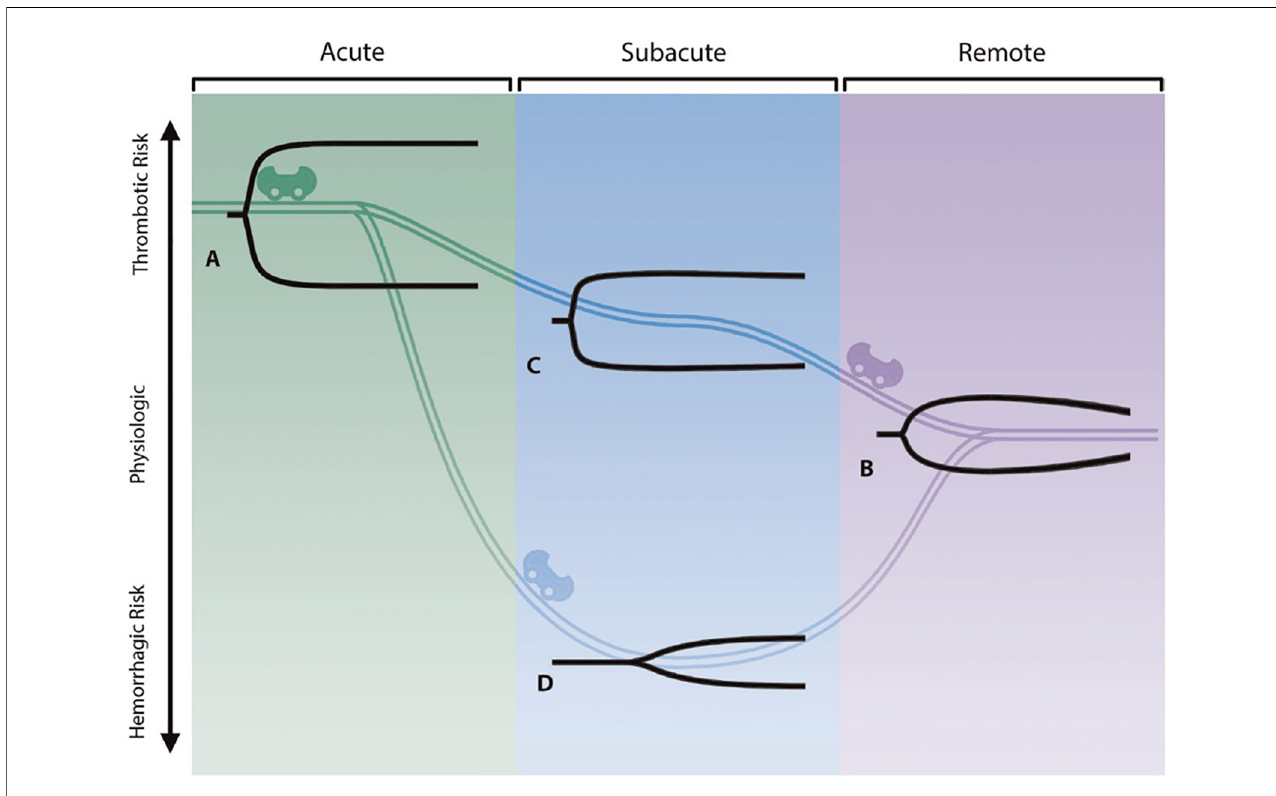
FIGURE 1 The three stages constituting the “ rollercoaster ” phenomenon of COVID-associated coagulopathy, as determined by thromboelastography (TEG). See original publication for detailed explanation of the content